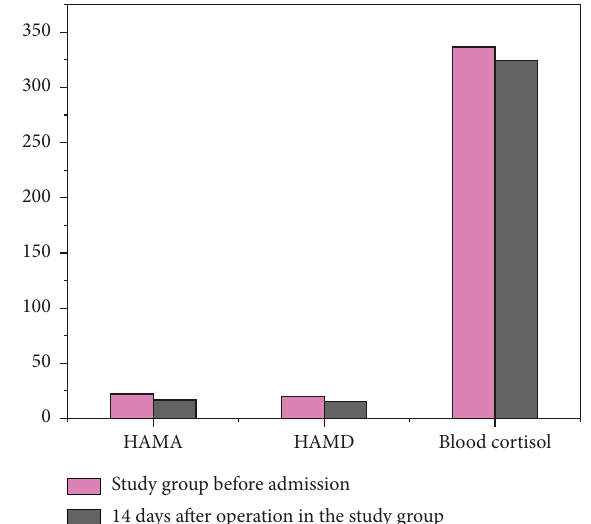
Figure 2: Comparison of ultrasonography and MRI results with postoperative pathological results.